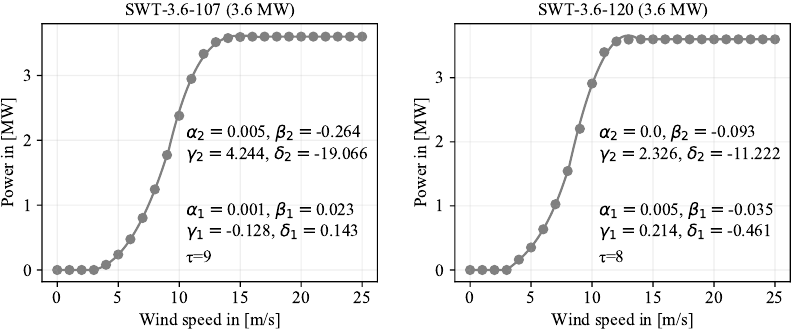
( b ) Power curve of wind turbine SG 11.0-200 DD (estimated from V164-9.5).